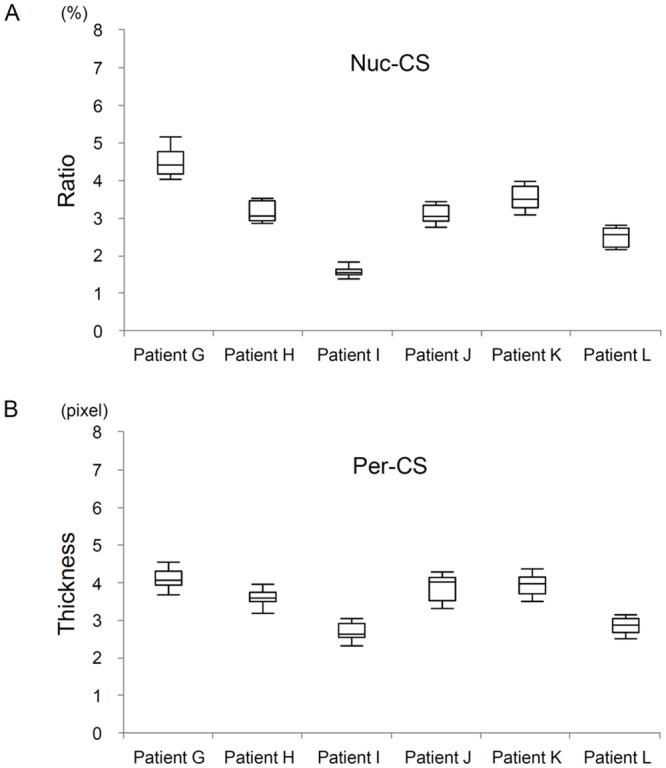
Variability in the Nucleoplasmic Chromatin Score (Nuc-CS) and the Perinuclear Chromatin Score (Per-CS).The variability in Nuc-CS and Per-CS in 6 Group N patients was measured. Six patients (Patients G—L) were randomly selected from Group N. In each patient, Nuc-CS was assessed for all observable nuclei; the variability is shown in the box plot. The top and bottom error bars represent the 90th and 10th percentiles, respectively. The top and bottom tiles of the box represent the 75th and 25th percentiles, respectively. The horizontal bar within the box represents the median.